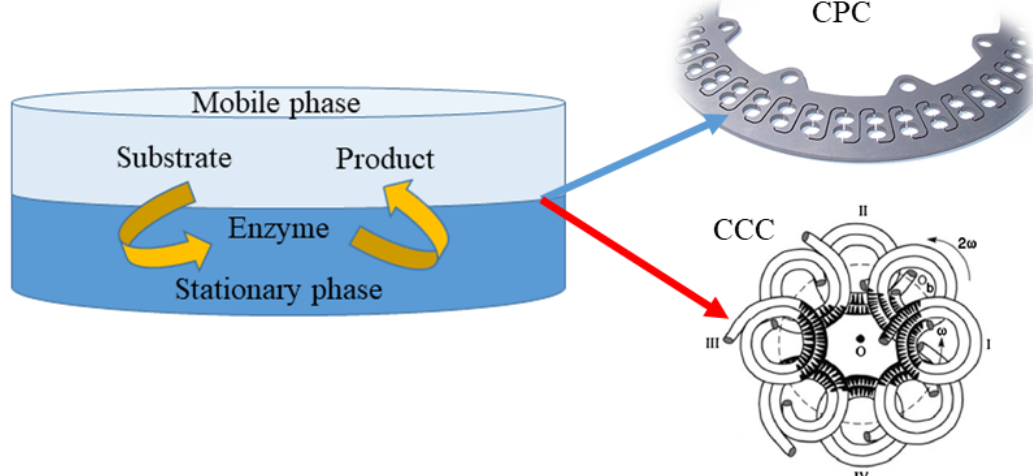
Figure 2. Schematic representation of approaches for the preparative isolation and purification of natural products using counter current chromatography (CCC) and centrifugal partition chromatography (CPC).